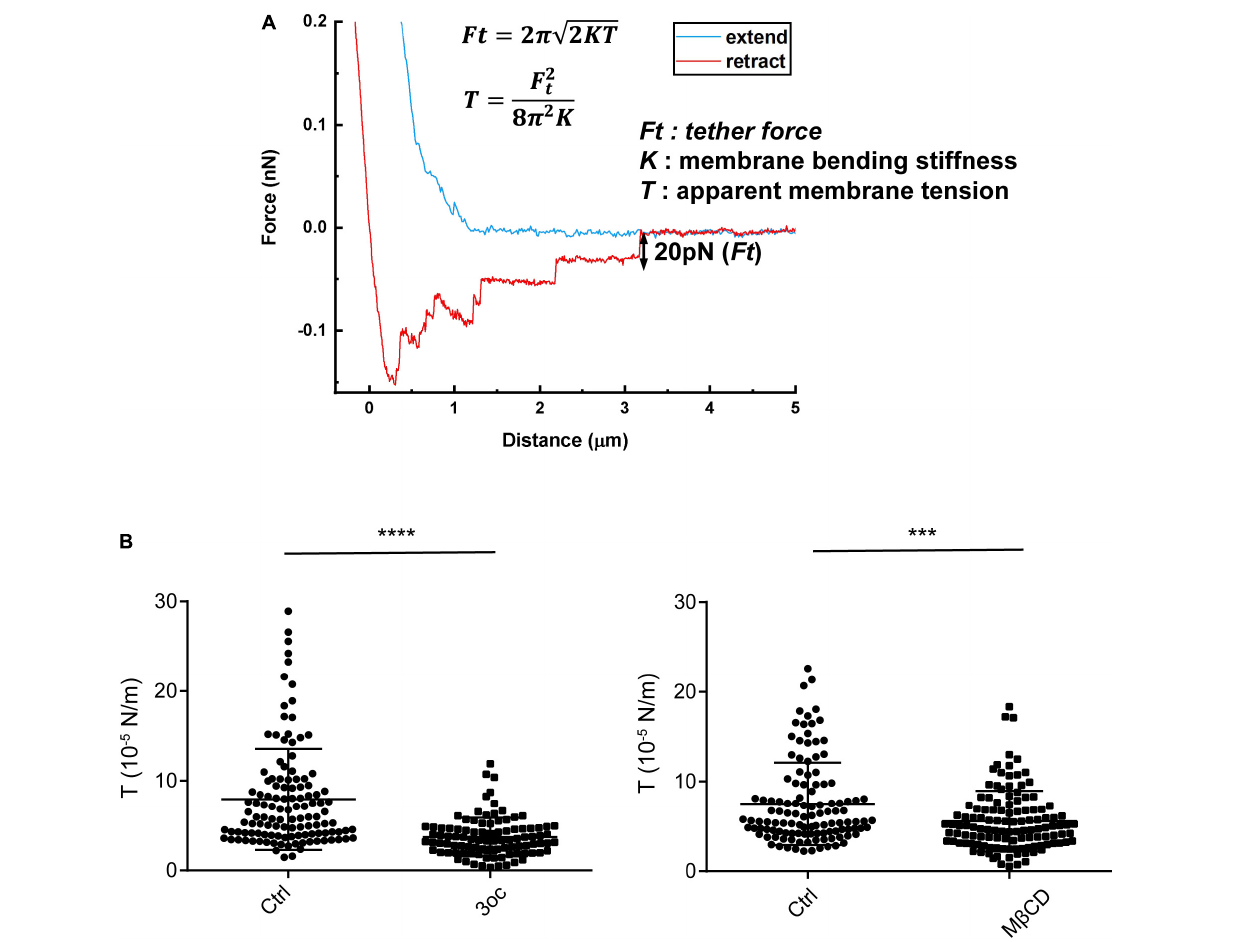
FIGURE 3 | Membrane tension probed by atomic force microscopy (AFM)-based tether force measurements. (A) A typical force curve showing membrane tethers was pulled out from the cell membrane and broken in a stepwise manner. The last step size (i.e., tether force, Ft) was used to compute apparent membrane tension (T), based on the formula (inset), where K is membrane bending stiffness and is about 3 × 10 - 19 N/m on average. (B) Membrane tension of Hela cells in resting state and after the treatment of 3oc and M β CD, respectively. For 3oc and M β CD experiments, force probing was started after the 15-min incubation. Each data point was from one force measurement, and for each cell, 3 measurements were performed and about 50 cells were probed for each experimental condition. **** P < 0.0001 and *** P < 0.0003 as measured by an unpaired t